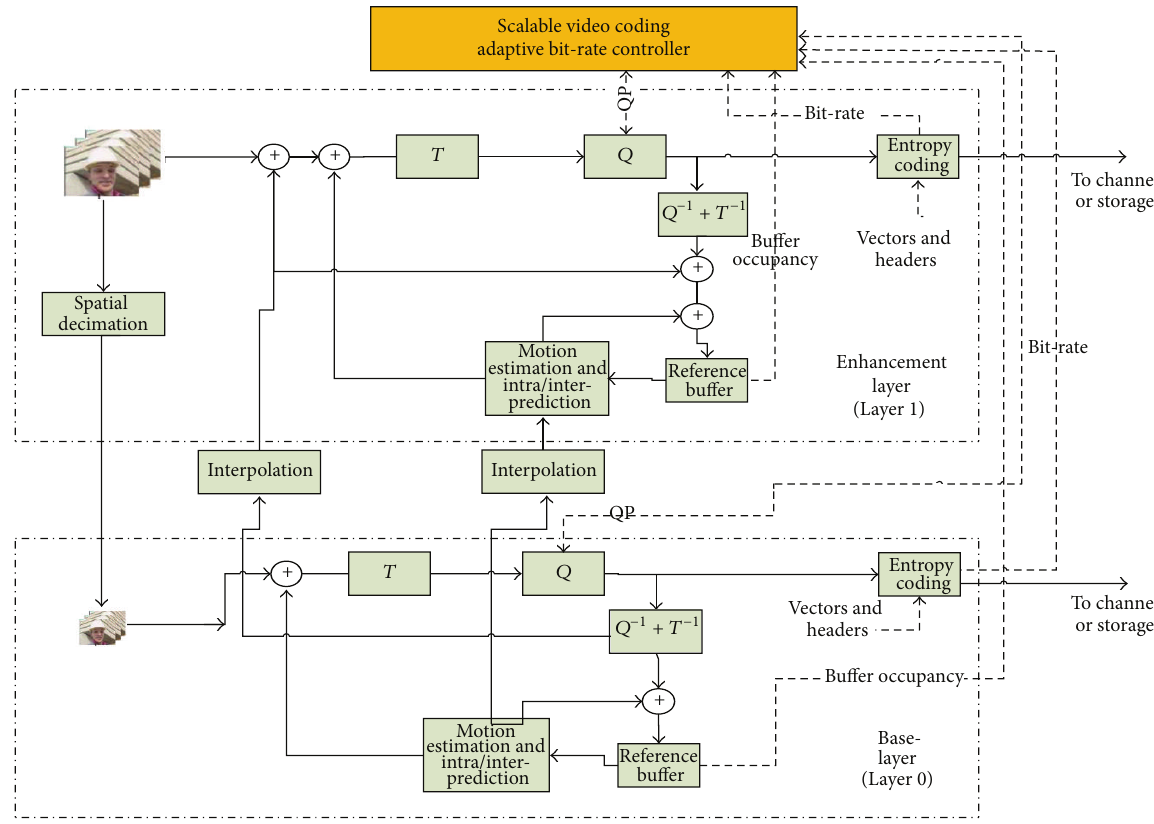
Figure 7: The block-diagram for performing the presented adaptive spatial bit-rate control for the scalable video coding (for simplicity, only two layers—Layer 0 and Layer 1—are